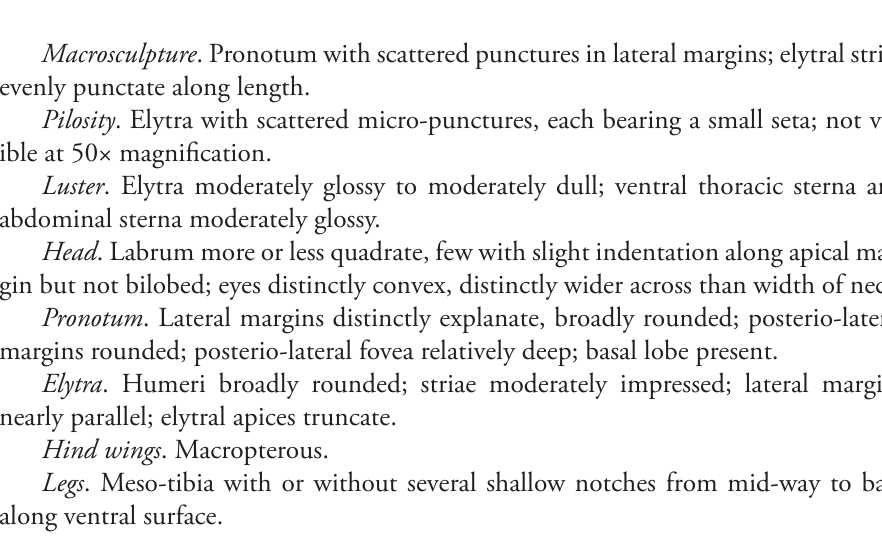
Macrosculpture . Pronotum with scattered punctures in lateral margins; elytral striae evenly punctate along